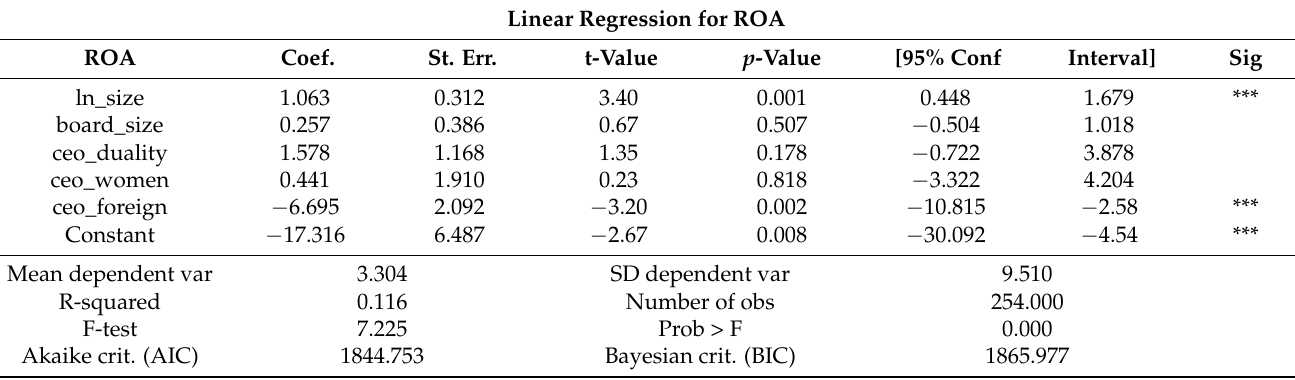
Table 5 repeats the same set of regression estimations for the independent variables of CEO characteristics. In the case of the upper panel with the ROA indicator, the size variable is positively associated with this performance measure, whereas having a foreign CEO is negatively associated. In the case of the ROE and Tobin’s Q indicators, the results of the middle and lower panels indicate that none of the CEO characteristics is statistically significant at the 10% level. This is an interesting result, which might arise from the exclusion of important board characteristics in the regression model. Table 5. OLS regression results with the CEO characteristics. Linear Regression for